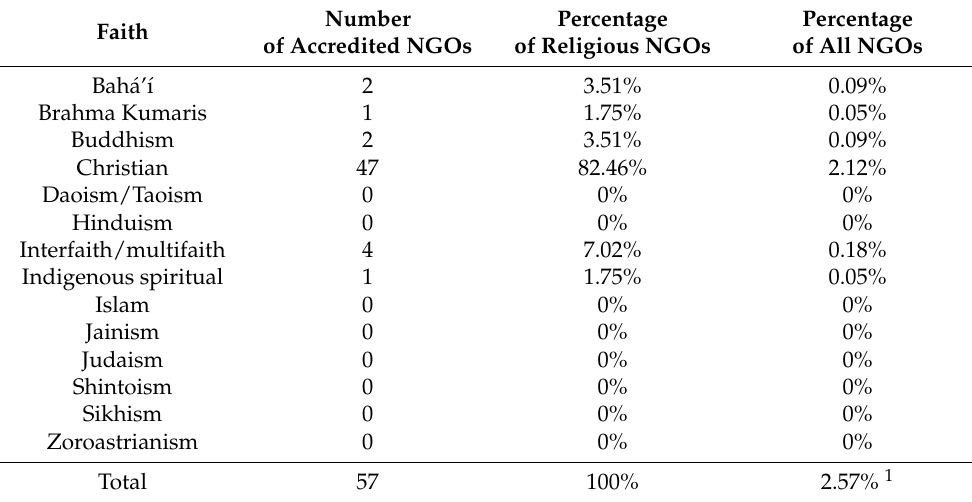
Table 1. UNFCCC-accredited religious